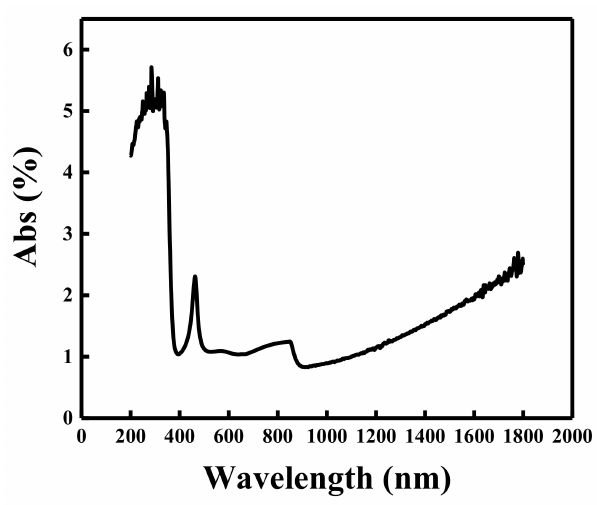
Figure 4. The absorption spectrum of